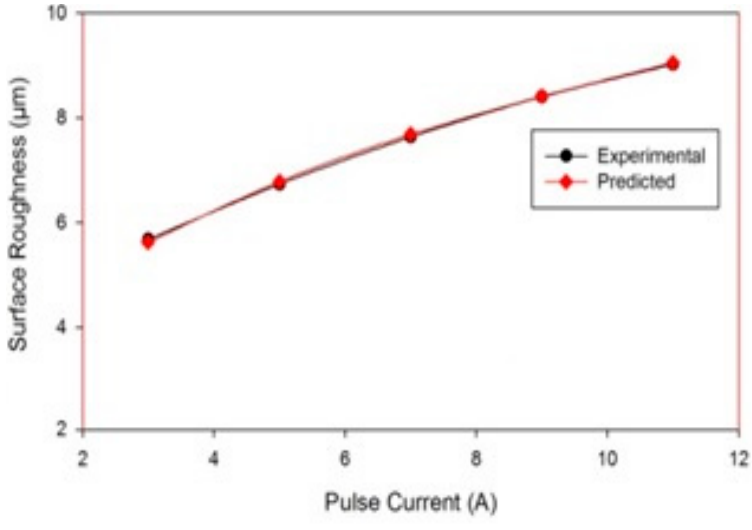
Figure 6. Effect of I p on SR.